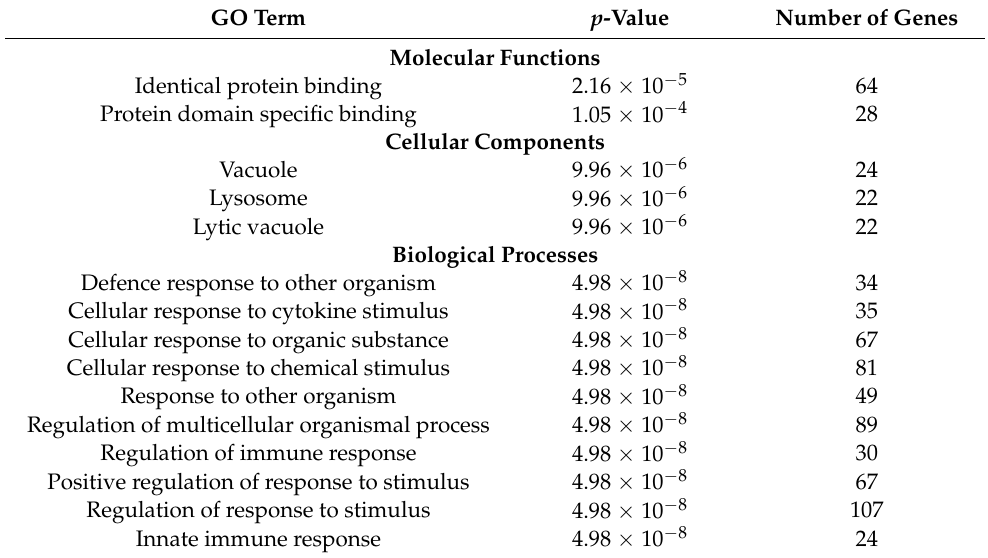
Table 6. Top 10 Gene Ontology (GO) terms for molecular functions, cellular components, and biological processes of spermatozoal transcripts across Merino, Dohne, and Poll